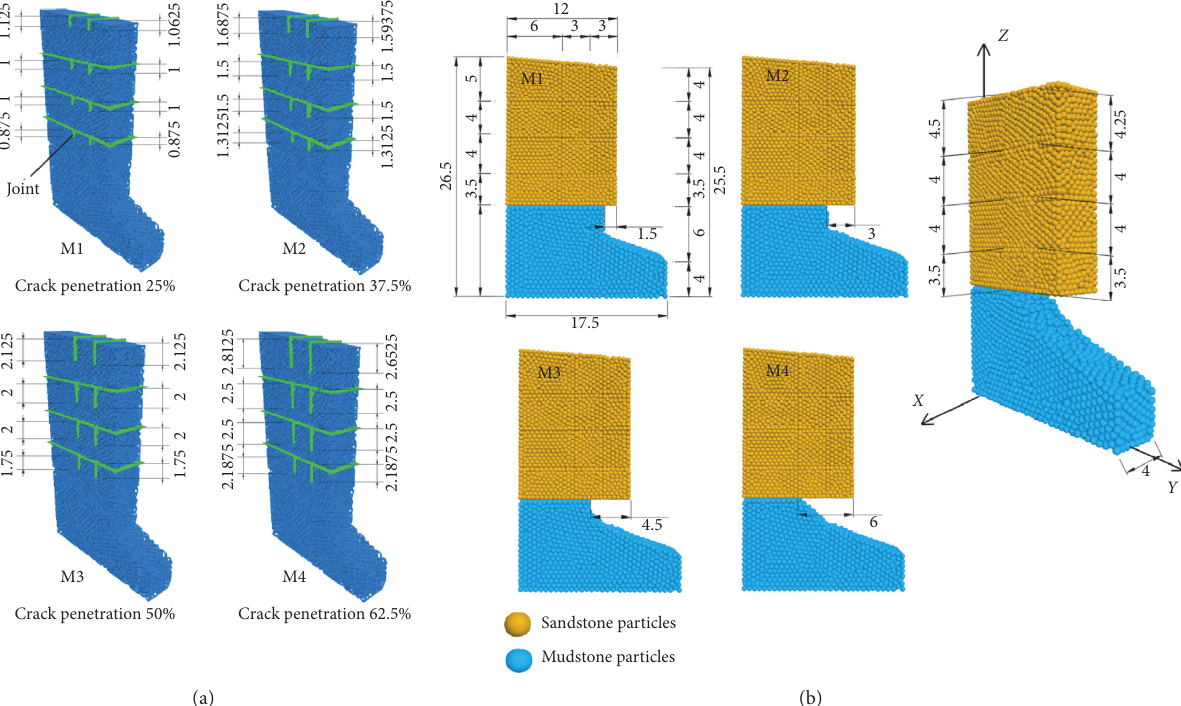
Figure 4: Layout of slope fissure and weathering of rock cavity (unit: m). (a) Fracture (DFN joint) and force chain grid. (b) Weathering layout of particle flow rock